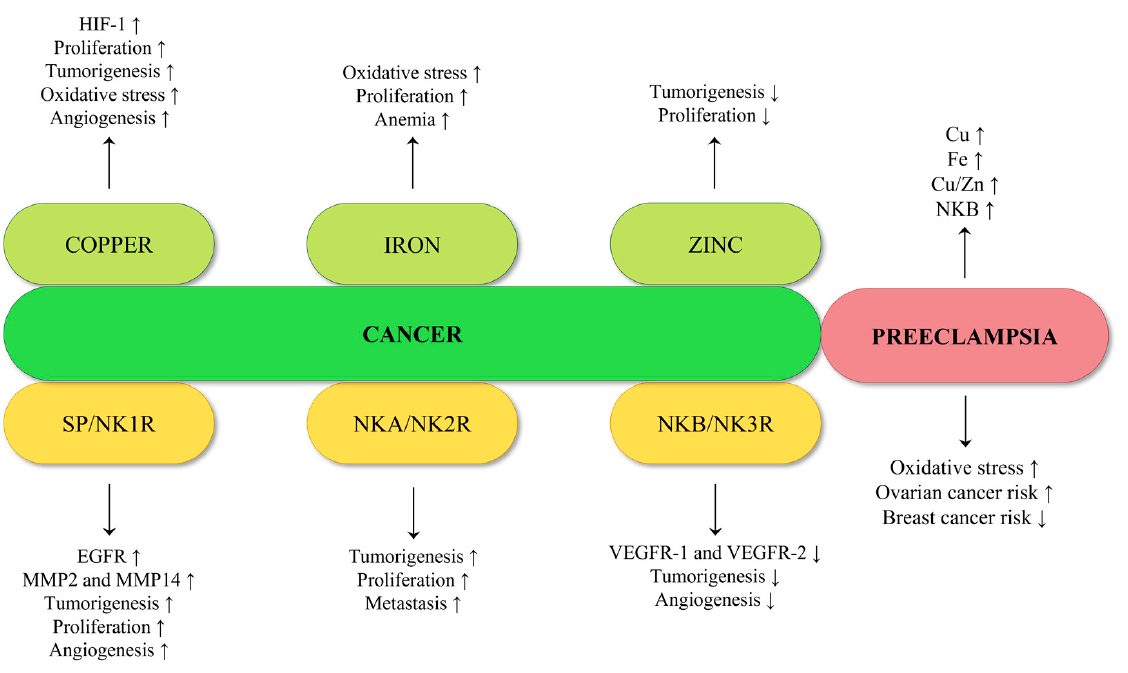
Figure 8. Summary of the effect of copper, iron, zinc, and tachykinins on carcinogenesis, and comparison with features present in preeclampsia.